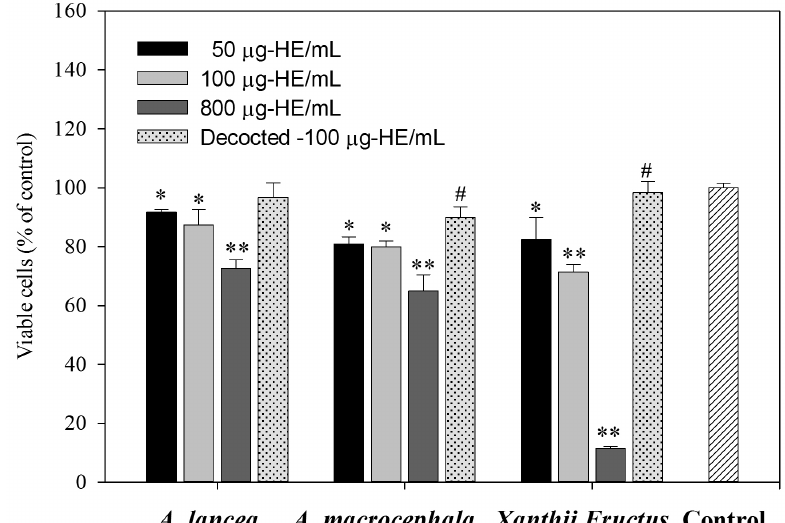
Figure 2. Viability was assessed using an MTT assay after 48 h treatment with the indicated agents. Media only was used as the control. Values represent means and standard deviation of 4 independent experiments. *, p < 0.05; **, p < 0.01, control versus HEs. # indicates a significant different between the HE treatments and decocted 100 μ g/mL herbal extract, p <